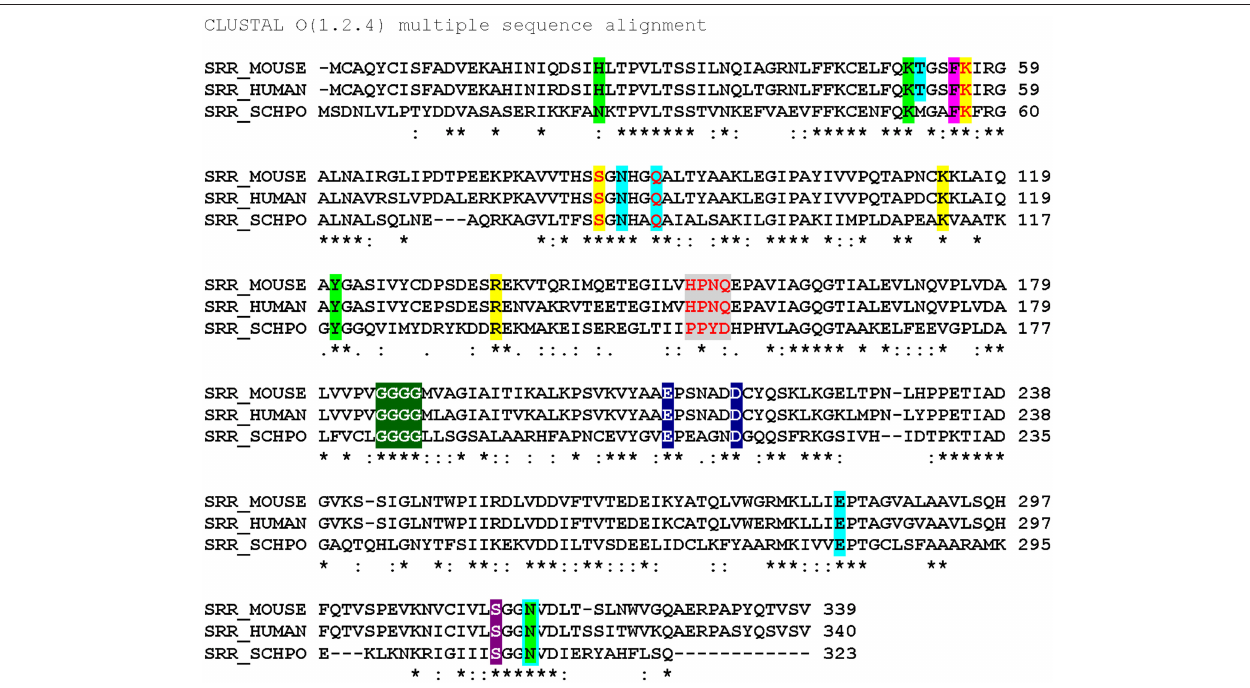
FIGURE 3 | Sequence alignment (Clustal O) of SR from mouse, human and S. pombe . Color code: ATP binding site (lime); ATP hydrogen bonding network (cyan highlight or outline); π -stacking residue (magenta) and catalytic residues (yellow); “triple serine loop” region by analogy with aspartate racemase (gray); tetraglycine loop (green); divalent cation binding site (navy blue); pyridine-N-protonating residue (violet). Red letters indicate positions that have been mutated. * conserved residue: strongly similar residues. Weakly similar